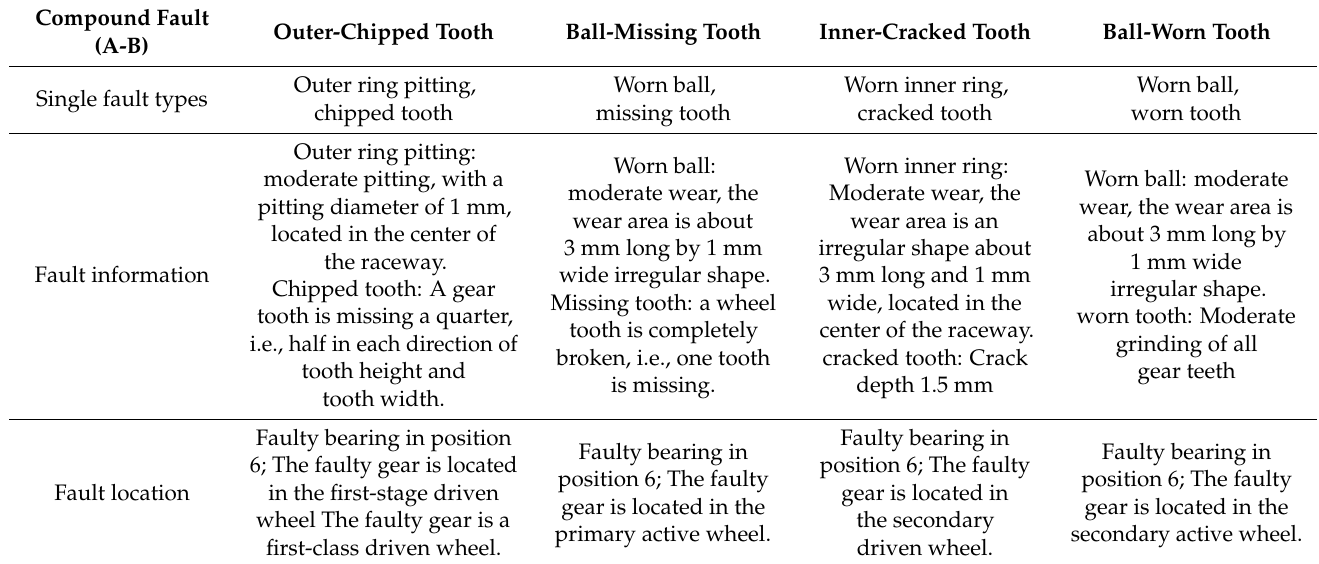
Table 1. The information on the compound fault status.